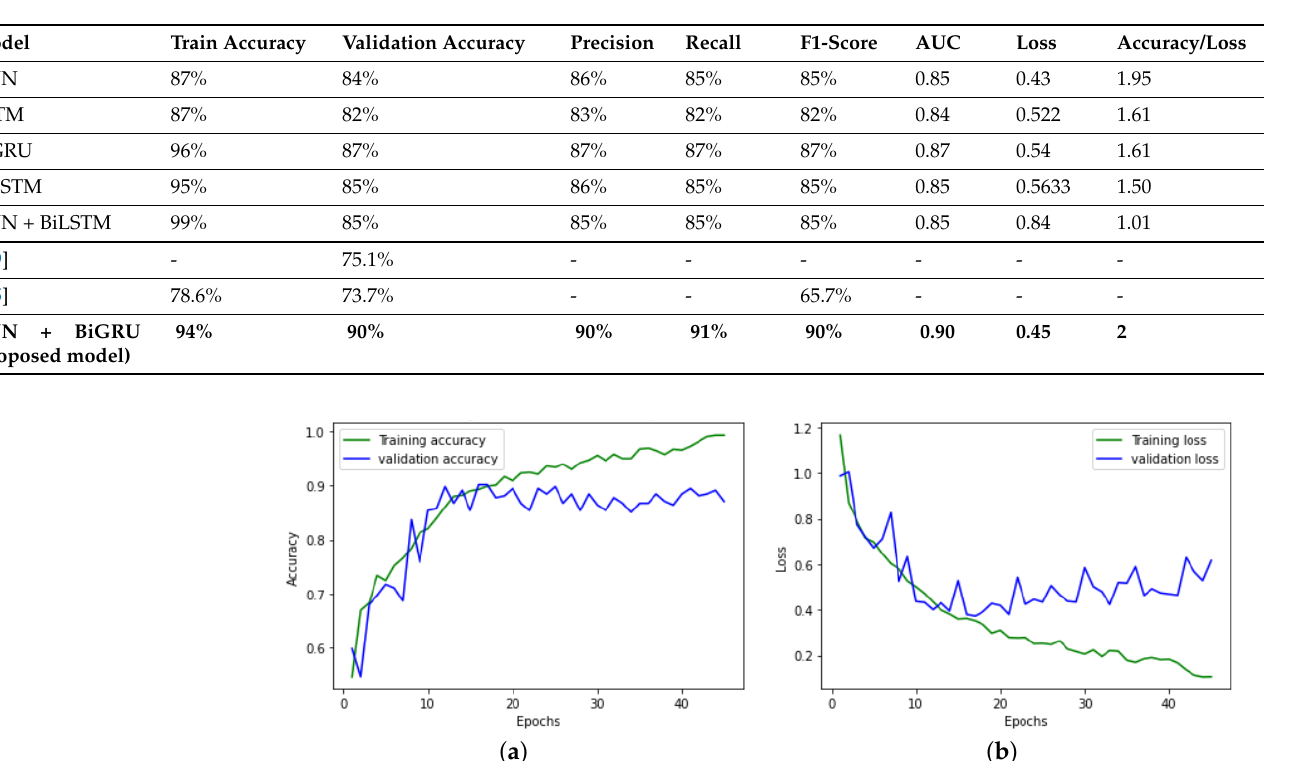
Table 2. Performance metrics of different deep learning models for heartbeat sound classification. Precision, Recall, and F1-Scores are macro averages. Columns of “Accuracy”, “Precision”, “Recall”, “F1-score”, and “AUC” are calculated on the validation set.